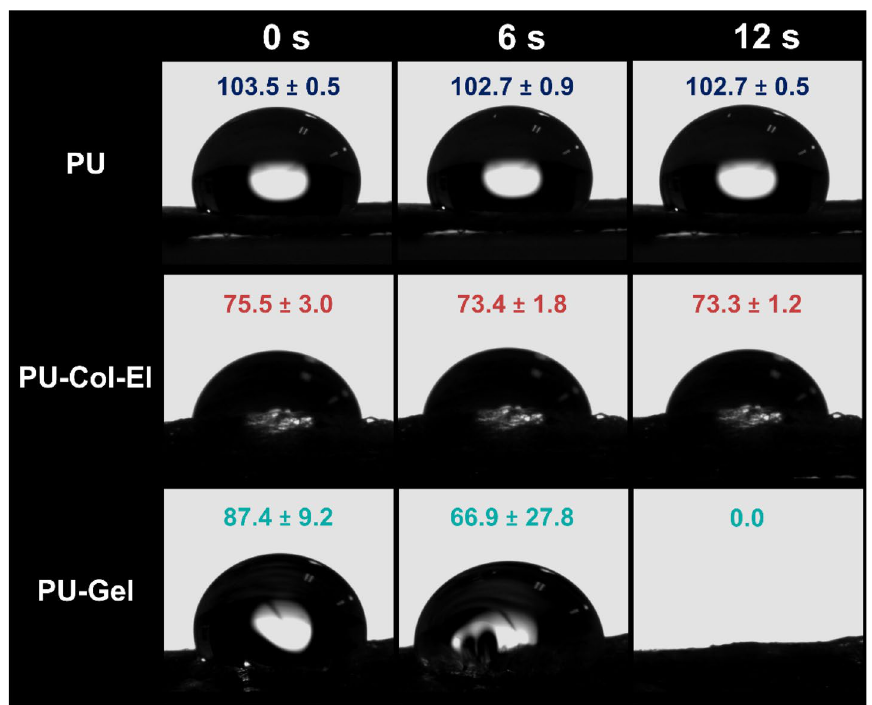
Figure 4. Dynamic contact angle measurements for the